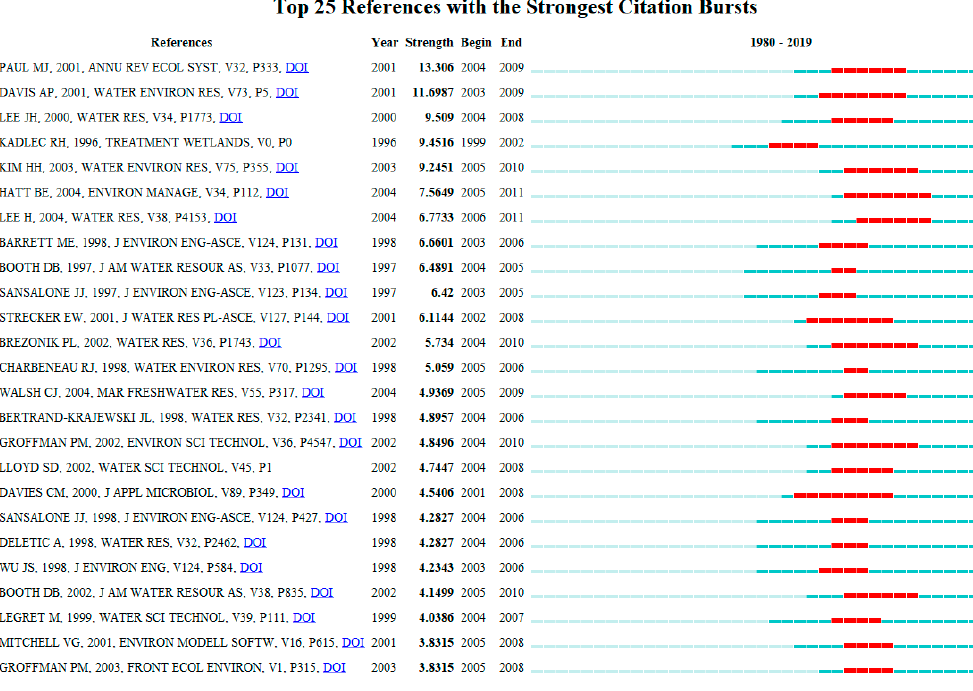
Figure 3. Top 25 citations with strong citation burst.